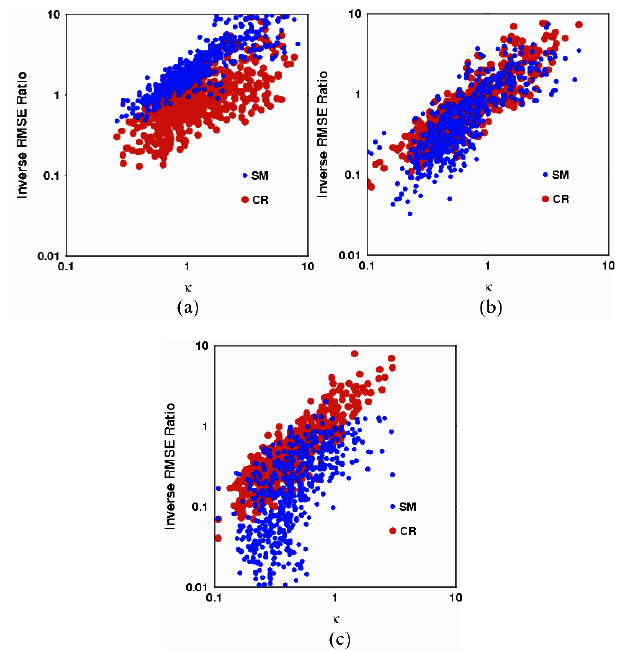
Fig. 7. Inverse RMSE ratio (i.e. RMSE revESP /RMSE ESP ) of CR and mean monthly SM forecasts at (a) lead-1 (b) lead-3, and (c) lead-6 plotted against κ parameter of each forecast period (i.e. 1 month, 3 months, and 6 months,